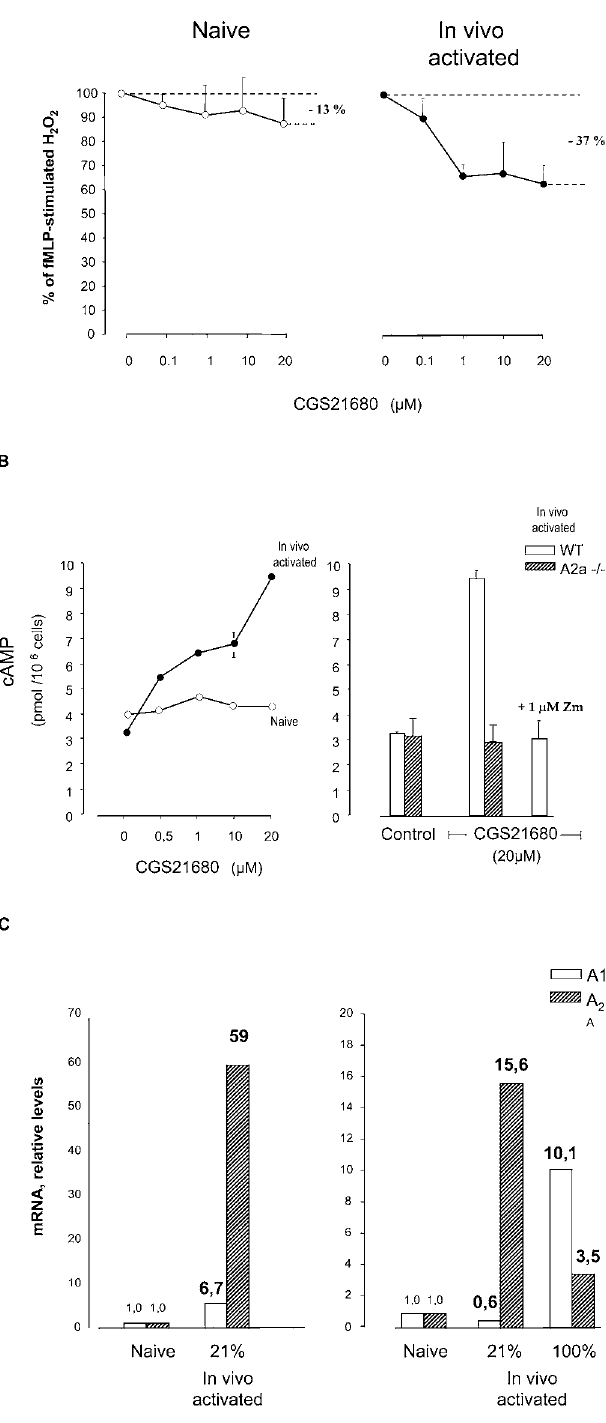
Figure 4. Evidence for the Up-Regulation of Immunosuppressive A 2A R Expression on In Vivo-Activated Granulocytes Isolated from Inflamed Lungs (A) The selective A 2A R agonist CGS21680 inhibited the fMLP- stimulated hydrogen peroxide production by granulocytes in blood of healthy mice to only a small degree, reflecting low levels of expression of A 2A R on naı¨ve blood granulocytes. In contrast, granulocytes recovered by BAL from inflamed lungs 48 h after